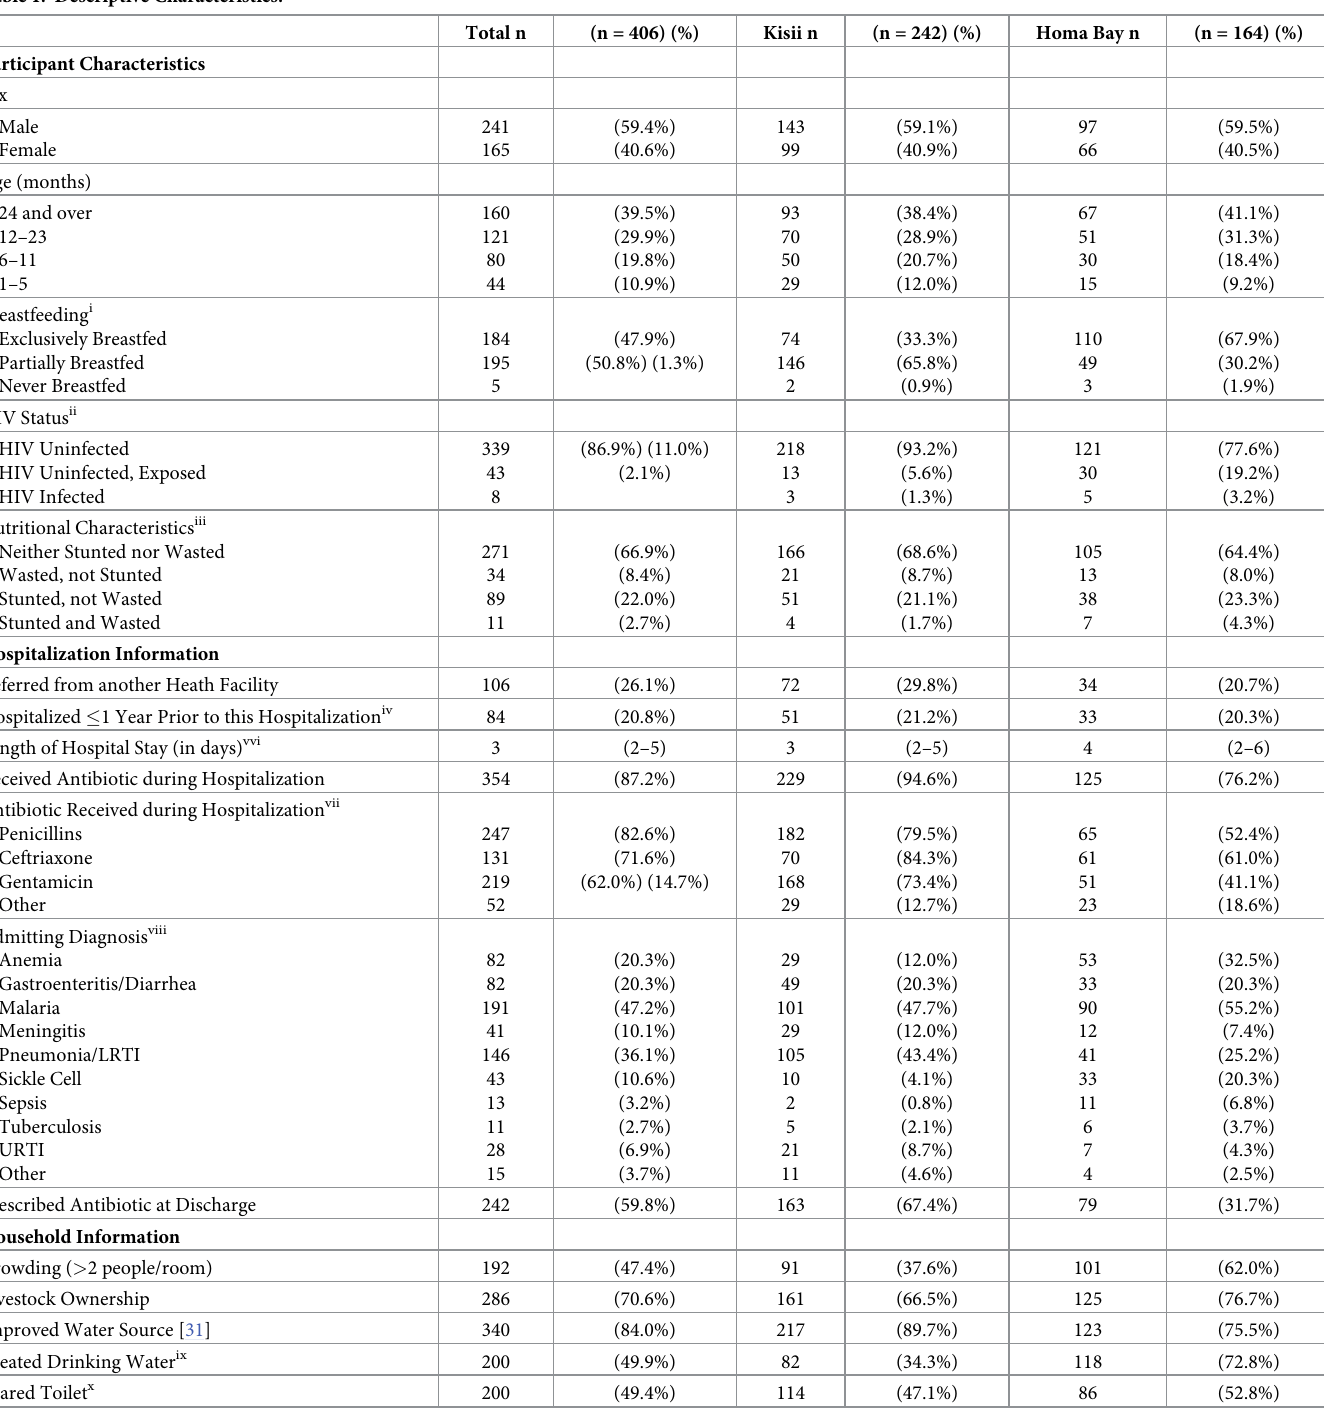
Table 1. Descriptive